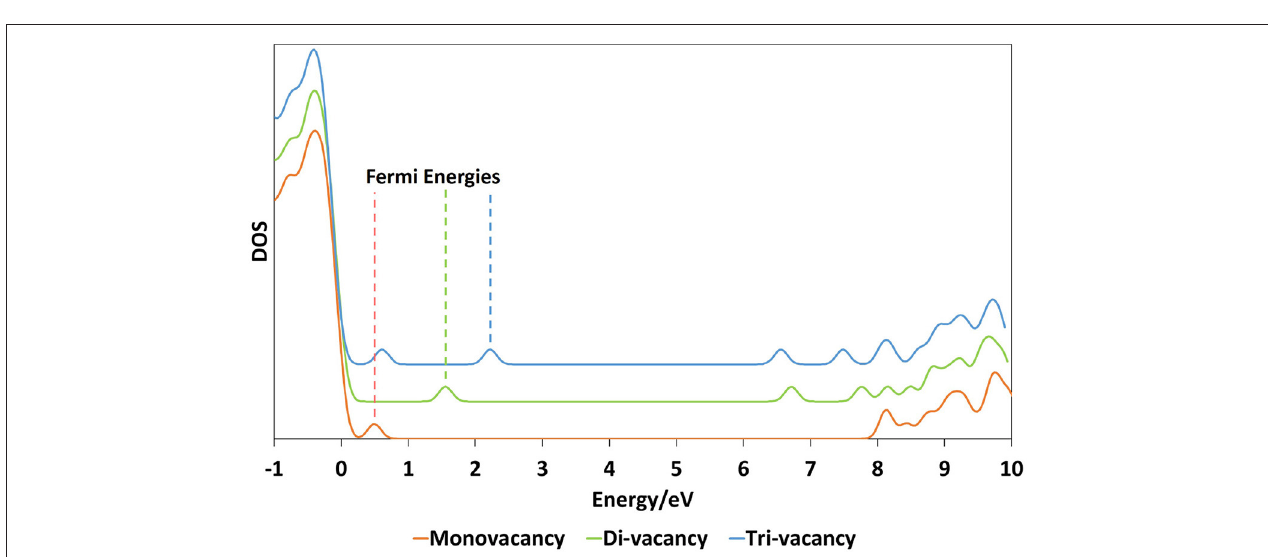
FIGURE 3 | Example density of states plots for a monovacancy together with its corresponding di-vacancy and tri-vacancy. For clarity, the energy levels on the plot have been broadened using Gaussians with a FWHM of 0.1 eV. The dotted lines indicate the position of the Fermi energy for each configuration.